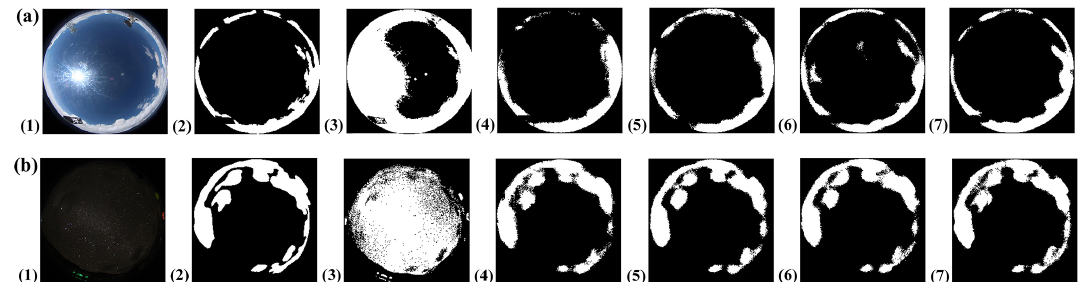
Figure 8. Results of different diurnal and nocturnal cloud segmentation algorithms. (a) Results of different diurnal cloud segmentation algorithms. (b) Results of different nocturnal cloud segmentation algorithms. (a1) Original diurnal ASI image, (a2) ground truth of the corresponding ASI image in (a1) , (b1) original nocturnal ASI image, (b2) ground truth of the corresponding ASI image in (b1) , (a3) , (b3) results of OTSU, (a4) , (b4) results of EFCN-32s, (a5) , (b5) results of EFCN-16s, (a6) , (b6) results of FCN-8s, and (a7) , (b7) results of the proposed EFCN-8s.